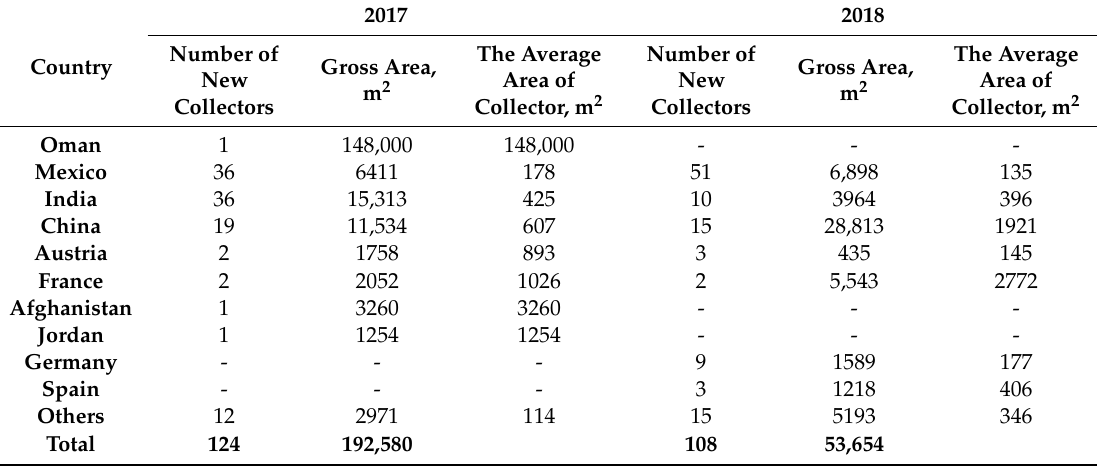
Table 3. Largest industrial solar collectors in the world. Source: authored based on data from [15] and https://www.solarthermalworld.org.